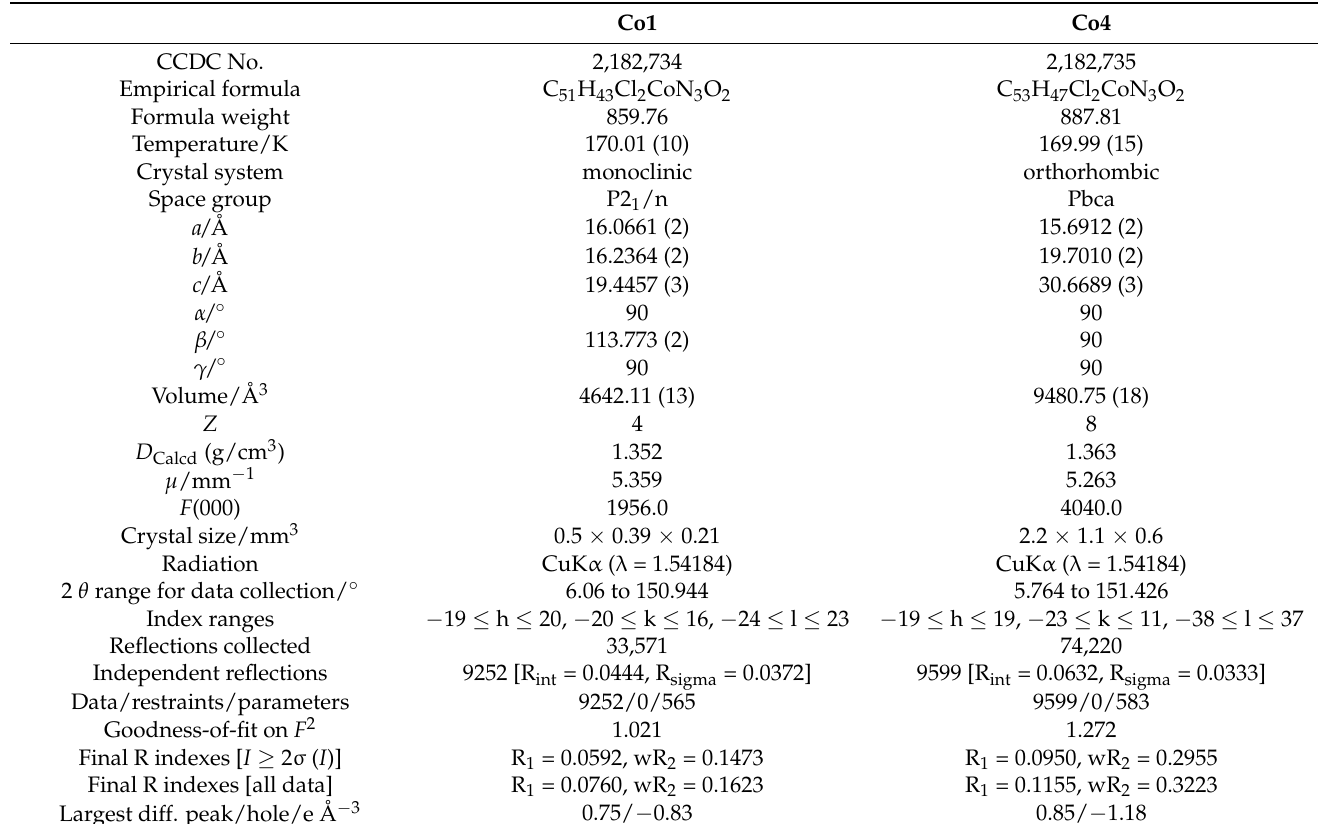
Table 6. Crystal data and structure refinement for Co1 and Co4